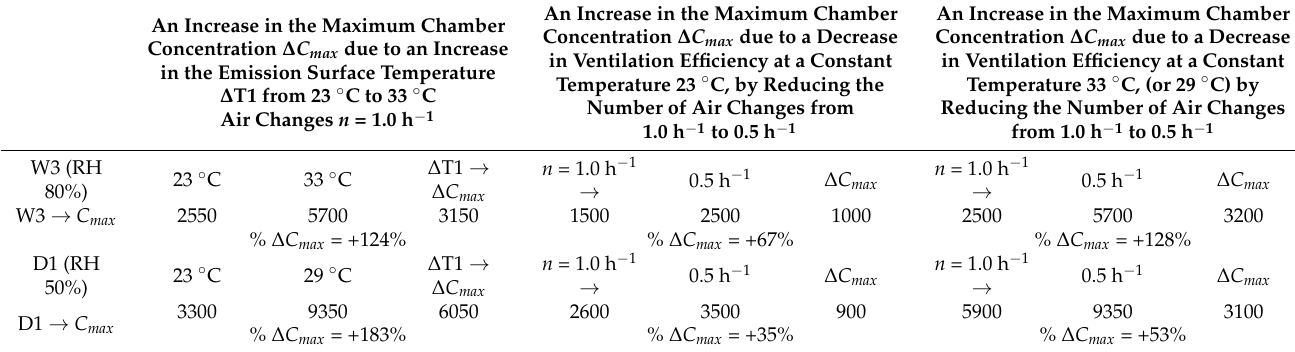
Table 5. Increase inTVOC concentration ∆ C max ( µ g m − 3 ) caused by an increase or decrease of parameters T1 and n . An Increase in the Maximum Chamber Concentration ∆ C max due to an Increase in the Emission Surface Temperature ∆ T1 from 23 ◦ C to 33 ◦